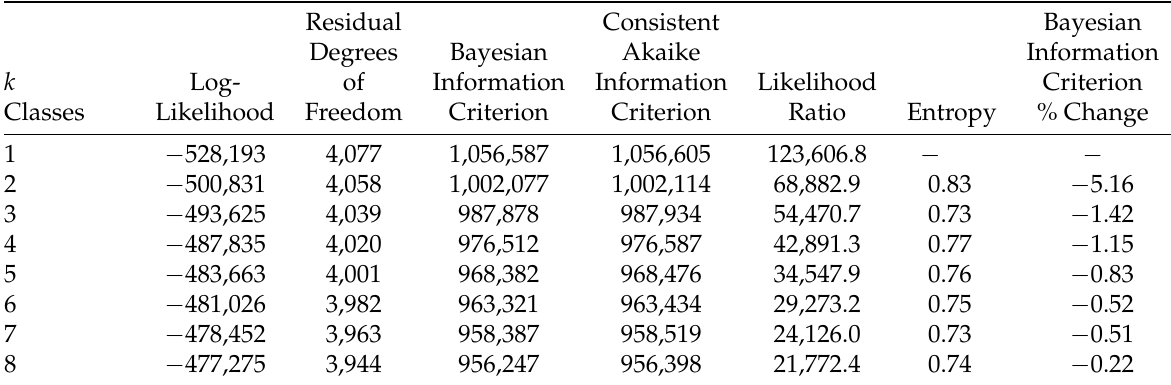
Table 2: Latent class model fit statistics (n =